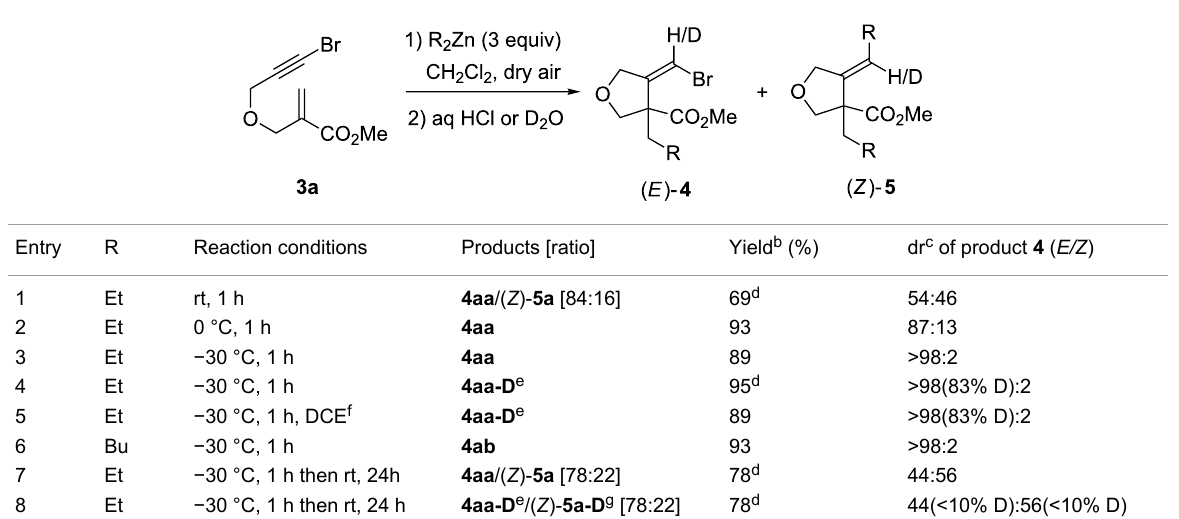
Table 2: 1,4-Addition/carbozincation of dialkylzincs on 3a in the presence of added air.